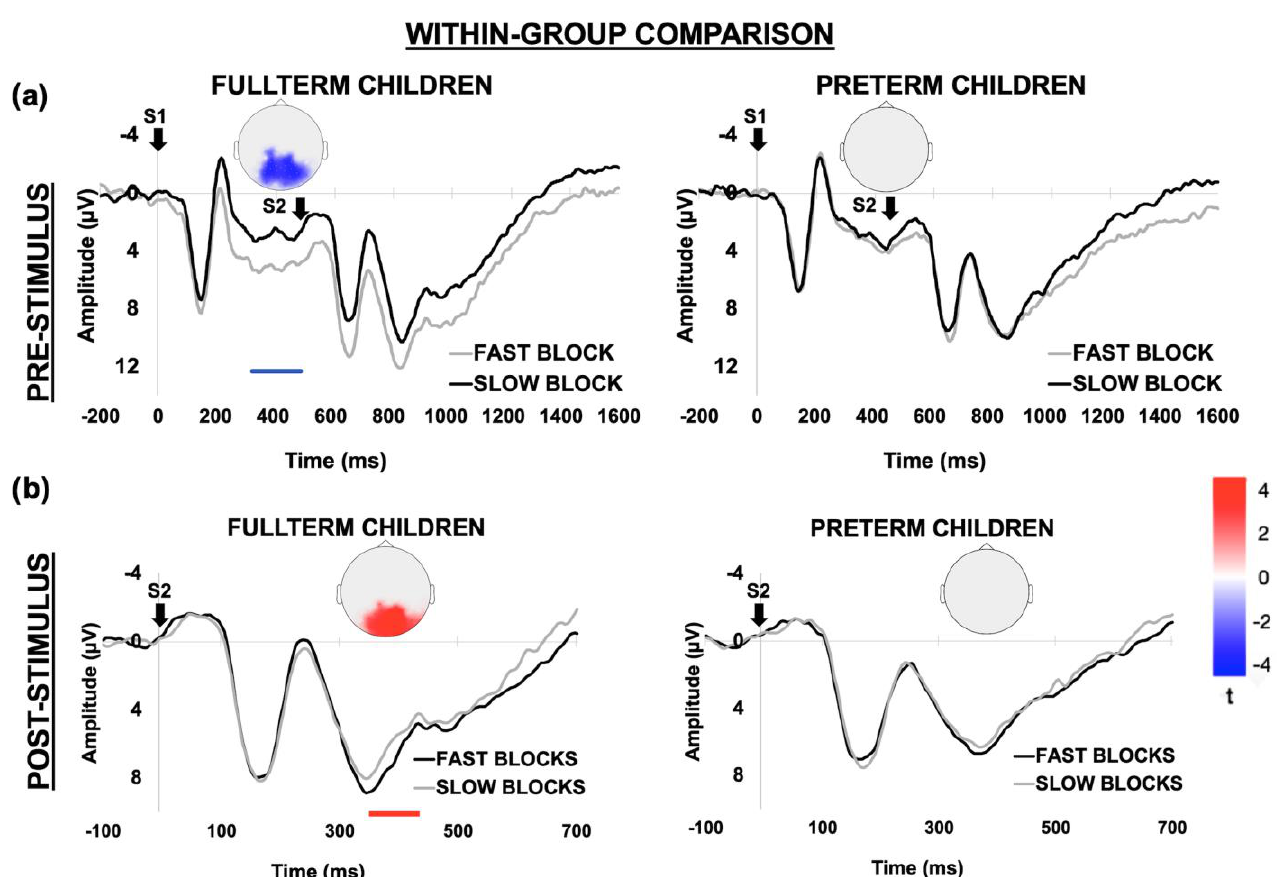
Figure 6. Within-group ERP comparison. The upper panel ( a ) represents the statistically significant electrodes exceeding the critical t-score threshold for statistical significance over the pre-stimulus window (stimulus expectancy/response preparation). The negative cluster indicates that ERP mean amplitude is significantly larger (i.e., more negative) in the fast than slow blocks over posterior electrodes in the FT group. This effect extended over a 300 ms window before S2 onset and was expressed by a CNV modulation (left panel). However, no significant block-dependent modulations were found in the PT group. The ERP waveforms below the scalp maps show the time series derived by averaging the electrodes included in the negative cluster. For visual comparison purposes, the time series derived from the same cluster of electrodes was shown for the PT group (right panel). The S1 at 0 ms indicates the ERP time locking, while S2 indicates the onset of the imperative stimulus. The lower panel ( b ) represents the same analysis performed over the post-stimulus window (stimulus processing/response implementation). The negative cluster indicates that ERP mean amplitude is significantly larger (i.e., more positive) over posterior electrodes in the fast than slow blocks for the FT but not PT group. The ERP waveforms below the scalp maps show the time series derived by averaging the electrodes included in the positive cluster. These clearly showed a larger P3 amplitude in fast than slow blocks only for FT (left panel). For visual comparison purposes, the time series derived from the same cluster of electrodes was shown also for the PT group (right panel). The S2 at 0 ms indicates the ERP time locking. For all comparisons the colored horizontal bars represent the timing of significant ERP